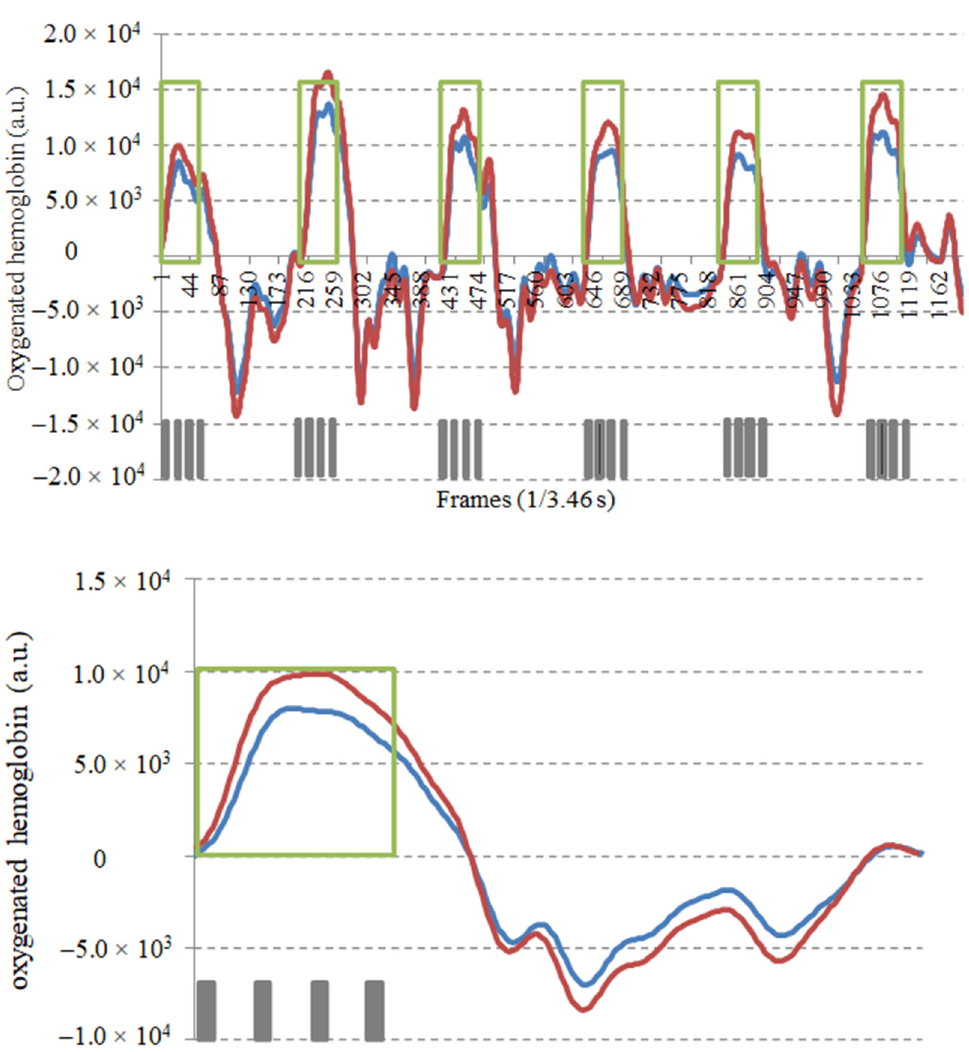
Figure 1. Method of calculation of cortical oxygenation. TOP: mean track of the 24 channels for each hemisphere during the six reaching and grasping tasks (represented in green; red: affected hemisphere; blue: unaffected hemisphere). BOTTOM: Mean traces of the six reaching and grasping cycles. In grey are represented the number of reaching and grasping repetitions performed by the patient. Cortical oxygenation (AUC) was calculated as the area under the curve for both hemispheres. The CMC was obtained by dividing each AUC for the number of repetitions.